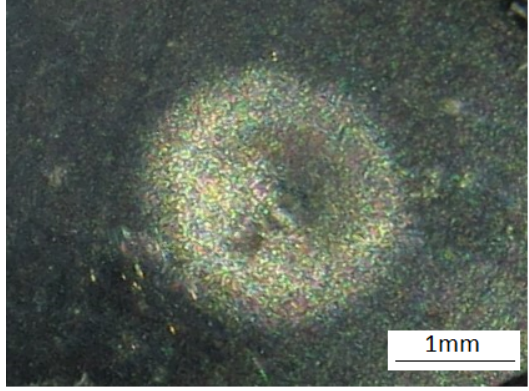
Figure 4 . The surface zone affected by the laser pulse.